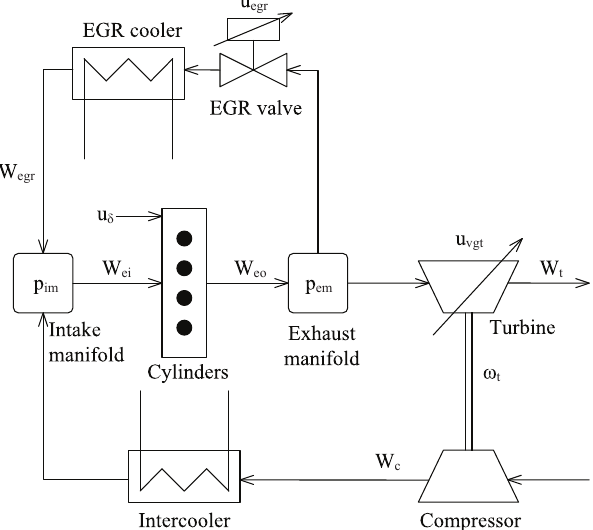
Figure 1. Schematic of the diesel engine model with exhaust gas recirculation (EGR) and variable geometry turbocharger